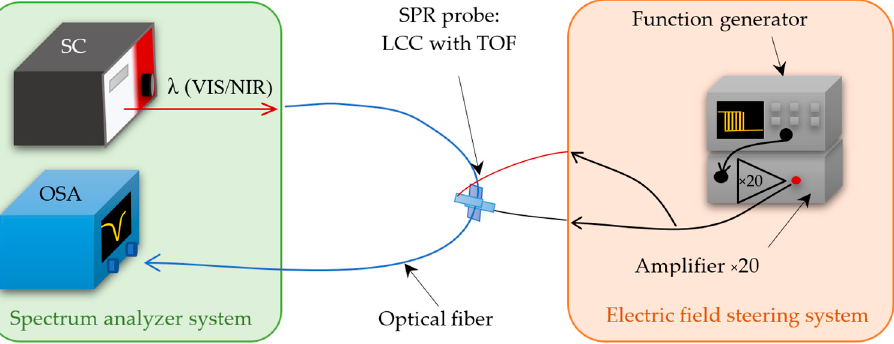
Figure 2. Scheme of the measuring system containing the spectrum analysis unit and the part responsible for controlling the LC molecules arrangement inside the LCC, as well.